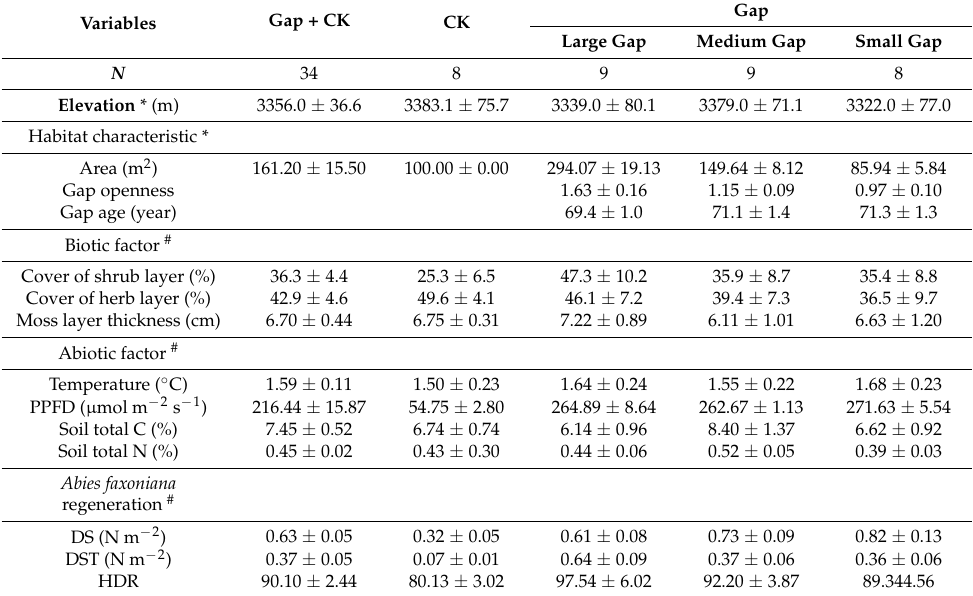
Table 1. Descriptive statistics for all variables used for the MANOVA analyses and structural equation model (SEM) analyses in our gap study of a subalpine coniferous forest (mean ± SE). The exogenous variables are denoted by * and the endogenous variable are denoted by #. DS, DST, and HDR represent density of Abies faxoniana Rehd. et Wils. saplings, density of Abies faxoniana small trees, and the ratio of height to diameter at breast height (HD ratio) of the tallest Abies faxoniana small trees, respectively; CK represents control check plots (non-gap plots). Gap Variables Gap + CK CK Large